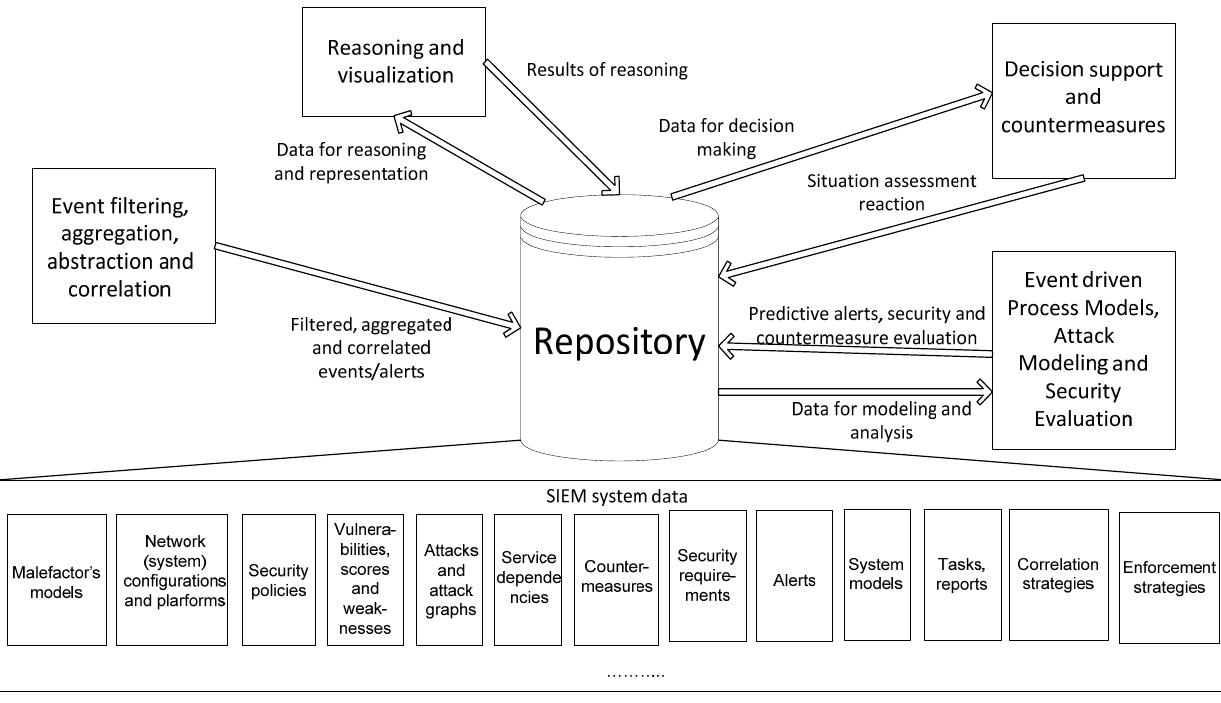
Figure 1. Main data flows with repository in Security Information and Events Management (SIEM)